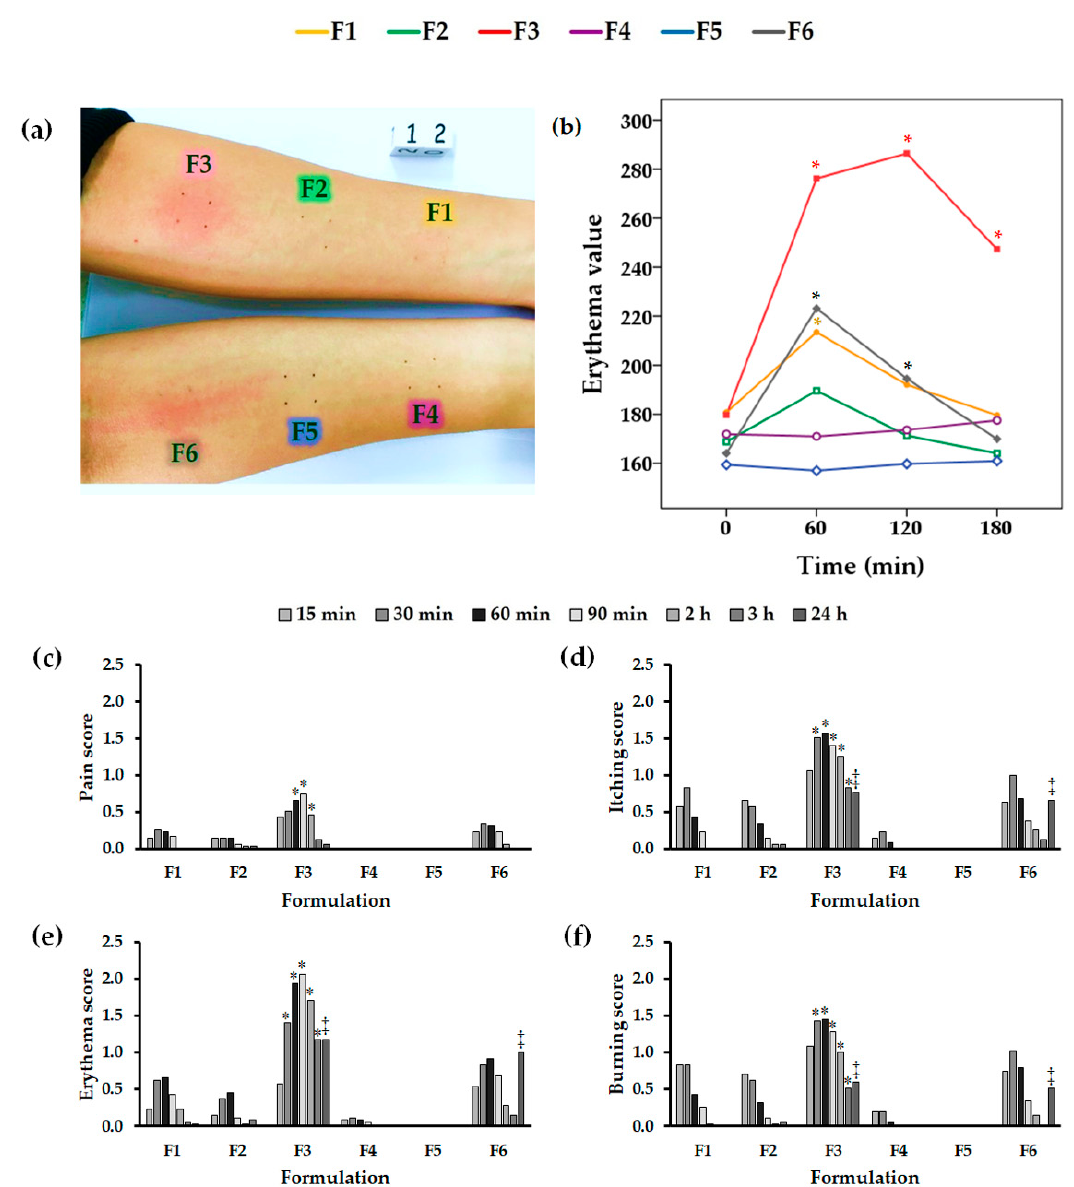
Figure 7. Erythema evaluation after applying each formulation on the human skin for 15 min and then removing it and leaving it on for 60, 120, and 180 min. ( a ) An example photo at 60 min; ( b ) erythema values determined with a Mexameter ® ; pain scores on a sensory scale at 15 min, 30 min, 60 min, 90 min, 2 h, 3 h, and 24 h, including for ( c ) pain, ( d ) itching, ( e ) erythema, and ( f ) burning. * The values are significantly different ( p < 0.05) from the values for the other formulations, ‡ The values are significantly different ( p < 0.05) from the values for the other formulations, except formulations F3 and F6. Note; F1: Gel NLC_C (chili-extract-loaded NLC-incorporated-in-gel formulation); F2: Gel NLC_B (blank NLC-incorporated-in-gel formulation); F3: Gel Chili (chili-extract-incorporated-in-gel formulation); F4: 5% sodium lauryl sulphate (SLS) solution; F5: Deionized water; F6: Commercial product.